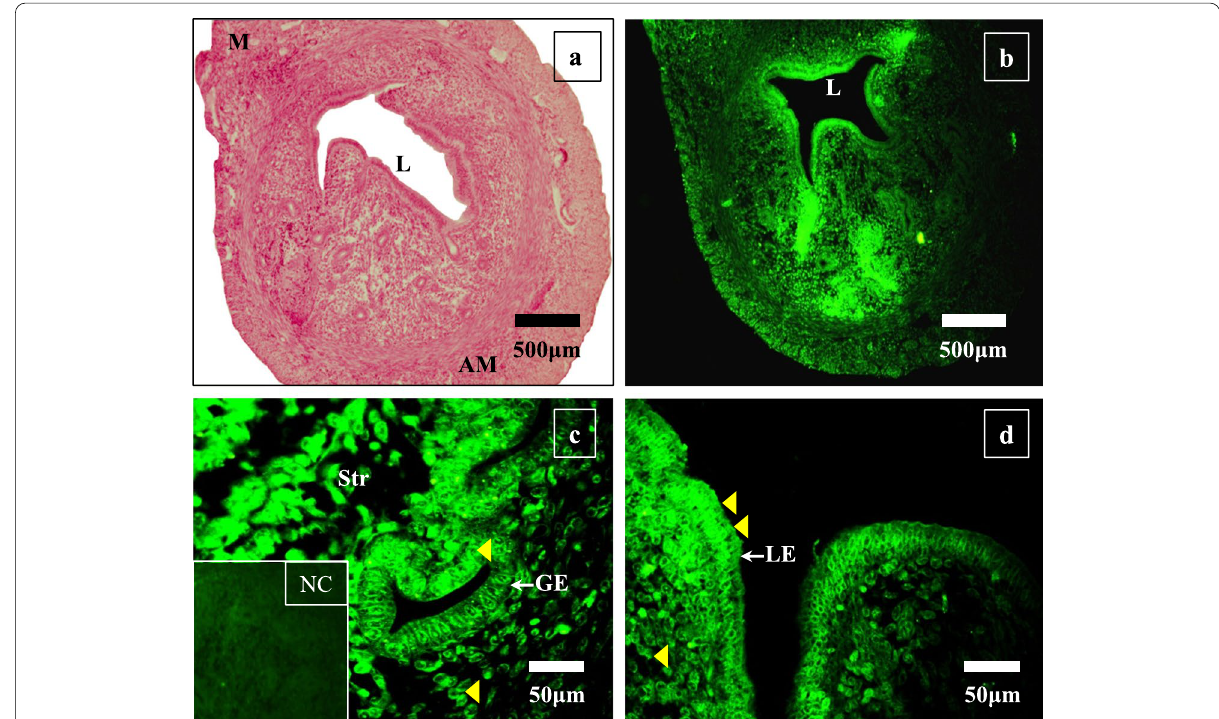
Fig. 8 Immunofluorescence of KLF5 on AntiE2-treated D4 mice uterus using FITC-conjugated antibody. The protein was localized in the luminal epithelium (LE), glandular epithelium (GE) of uterine glands, and stroma (Str). The arrowhead indicates the expression. Original magnification: a 5 b 5 , c 40 , d 40 . L, lumen; M, mesometrial pole; AM, antimesometrial pole; NC, negative × × ×